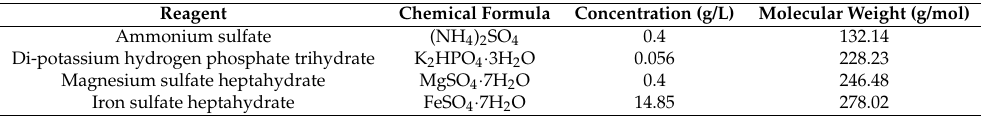
Table 1. Composition of the A. ferrooxidans culture